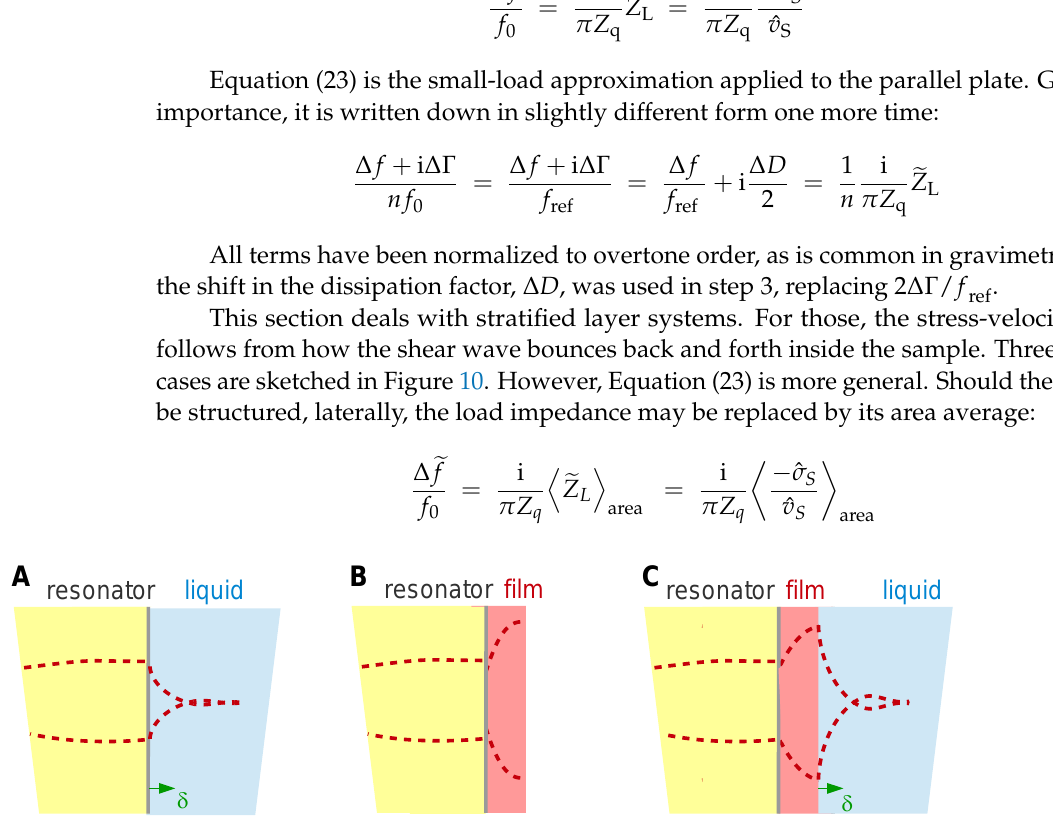
Figure 10. Three simple experimental configurations, which allow for an analytical prediction of ∆ f + i ∆Γ . The dashed lines show the displacement pattern of a shear wave in water ( A ), in a thin film ( B ), and in a sample containing a thin film in water ( C ). The graph is not to scale. The penetration depth of the shear wave in water, δ , is about 200 nm for a 5 MHz crystal. Films with a displacement pattern as shown in ( C ) are a few tens of nanometers thick.